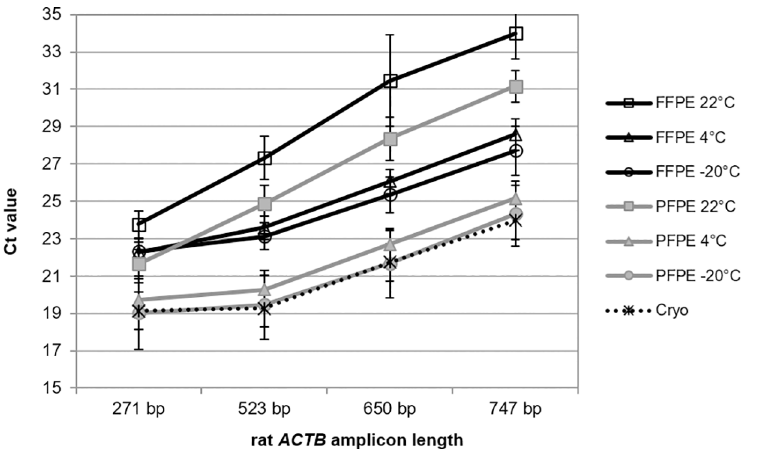
Fig 8. Improved qPCR-performance of DNA from PET blocks stored for 9 years at lower temperatures. FFPE and PFPE animal tissues were stored prior to DNA extraction for 108 months at different temperatures (22˚C, 4˚C, and -20˚C). qPCR was performed with four different SYBR-Green qPCR assays of the rat ACTB gene with amplicon length of 271, 523, 650 and 747 base pairs (bp). Triplicate extractions from each PET block were amplified. DNA from cryo- preserved rat tissue was used as reference, shown as dashed line. Mean Ct values with standard deviation from triplicate extractions from each of five different tissues (liver, kidney, spleen, lung and intestine) are shown for each